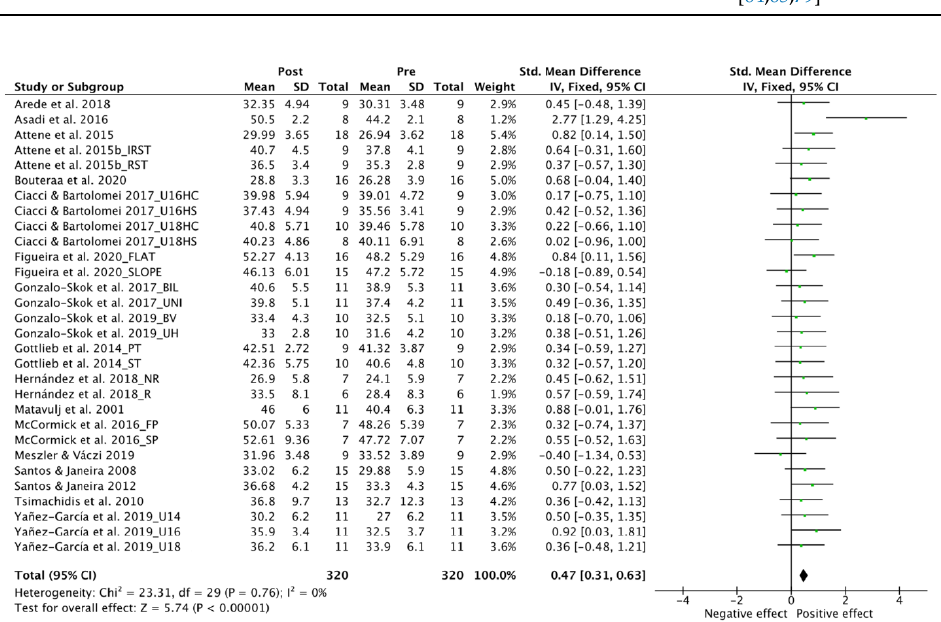
Figure 3. Forest Plot comparing the effect of multidisciplinary interventions on neuromuscular power vertical (NPV) [49,50,52,62 – 64,66 – 68,70 – 78].